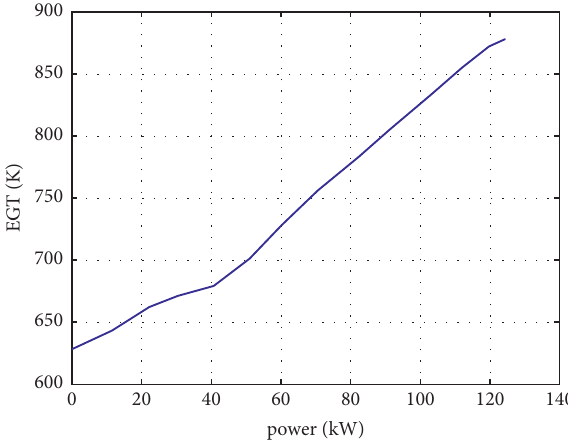
Figure 7: Stable power vs stable